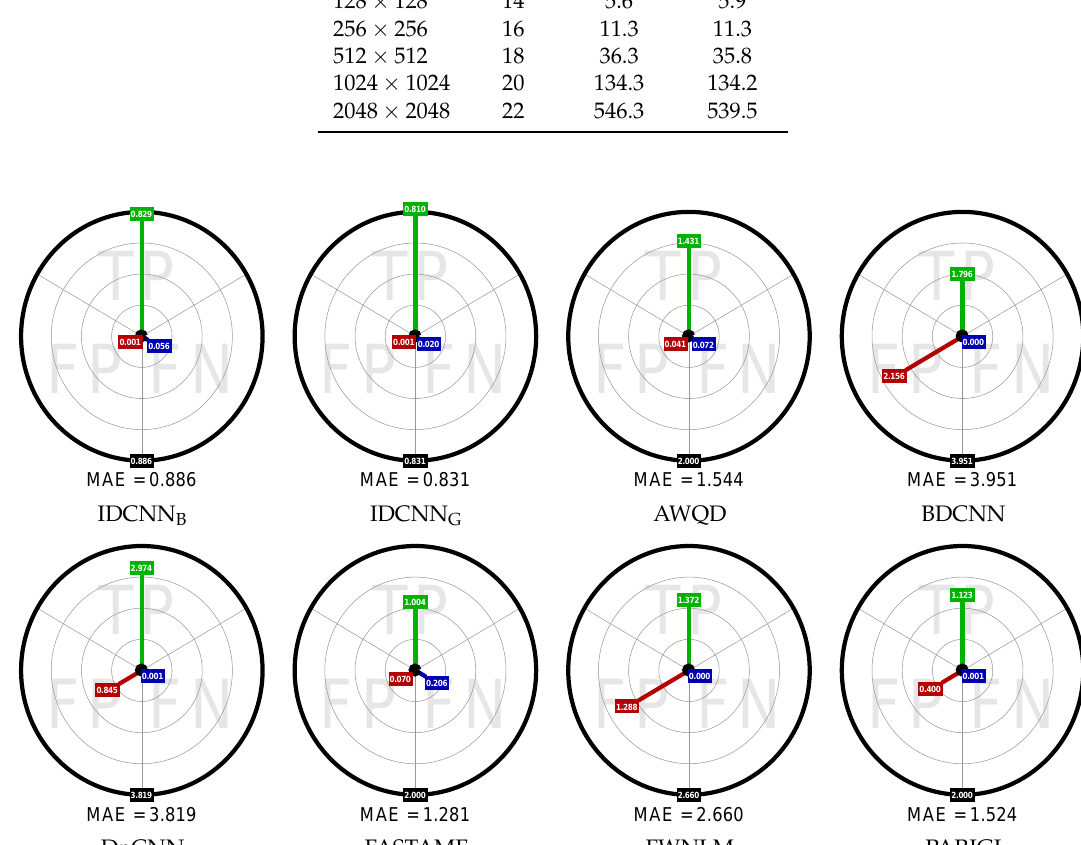
Figure 16. Diagrams that show what portion of the MAE error was caused by the improper decision of the used filter from classification perspective. These diagrams were obtained for the PEPPERS image ( ρ = 0.4).